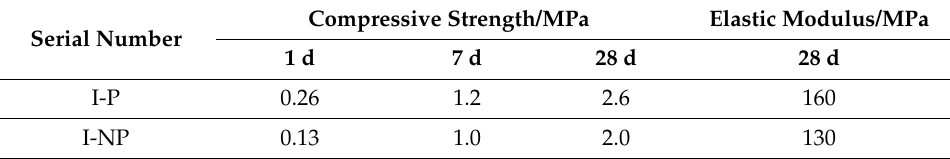
Table 4. Mechanical properties of the hardened CA mortar used for the fatigue test.